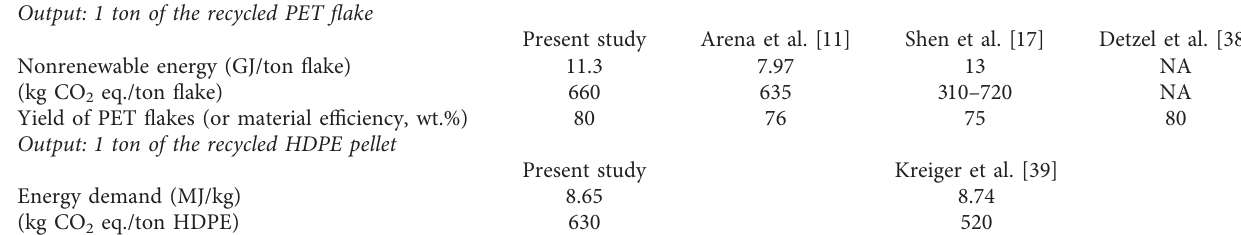
Table 13: Comparison of PET flake and HDPE pellet production with other